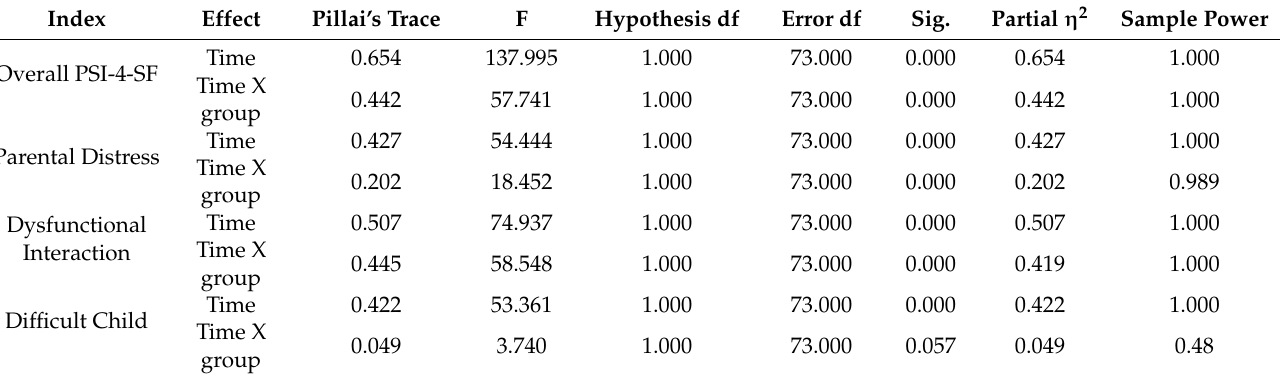
Figure 2. ( a – c ) Impact of parent–child physical activity program on sub-scales of stress, anxiety, and depression in the two groups. Note. Compared with the control group, * denotes p < 0.05, ** denotes p < 0.01. Compared with pre-test, # denotes p < 0.05, ## denotes p < 0.01. Table 6. Multivariate